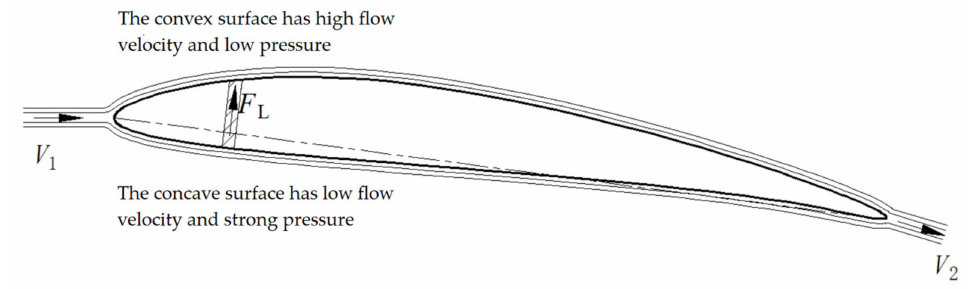
Figure 2. Static analysis of the differential pressure lift.